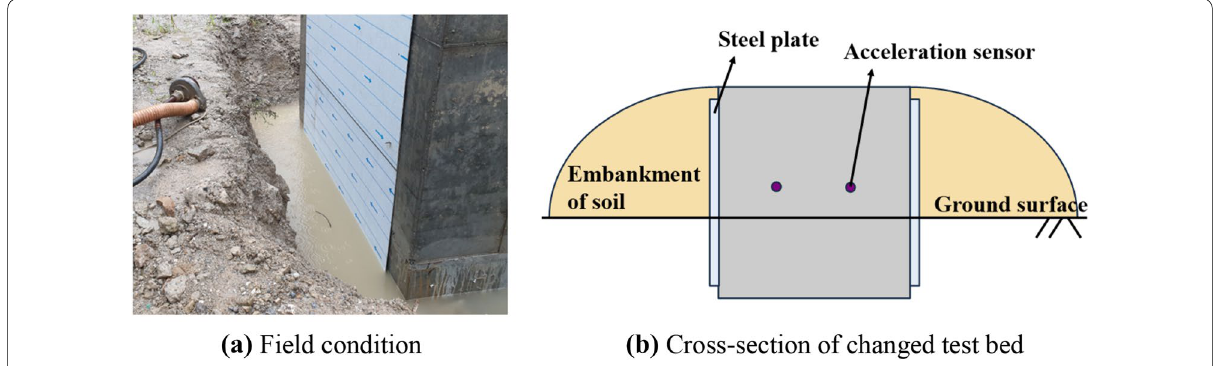
Fig. 10 Changed experimental conditions due to field condition on experiment